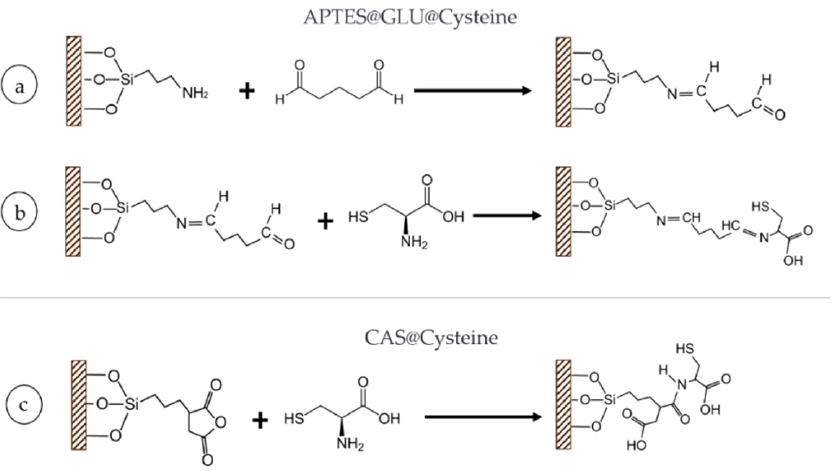
Figure 10. Schematic representation of the surface modifications with L -Cysteine. Substrate modification with ( a ) first step of APTES followed by Glutaraldehyde, ( b ) second step of APTES@GLU and then L-Cysteine, and ( c ) CAS and then L-Cysteine.